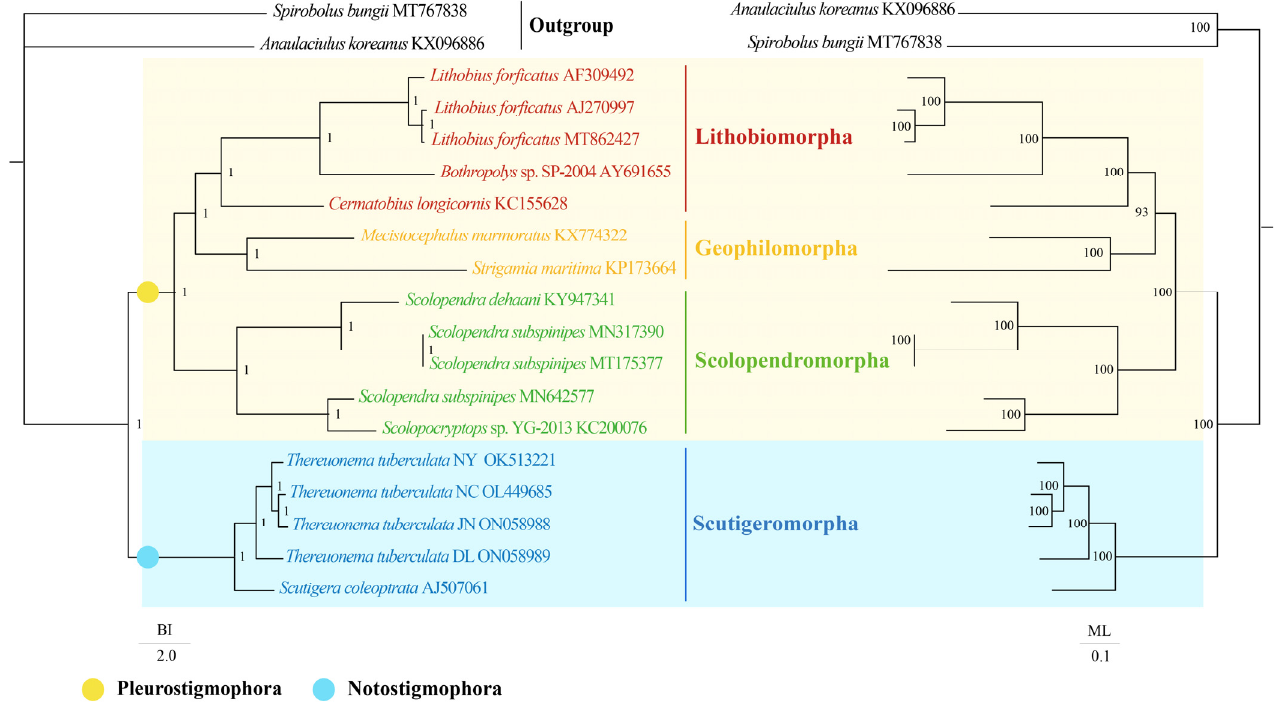
Figure 4. Phylogenetic relationships of Scutigeromorpha inferred from BI analysis ( left ) and ML analysis ( right ) based on 13 mitochondrial protein-coding genes including 17 Chilopoda species. Two species of Diplopoda ( A. koreanus and S. bungii ) were chosen as outgroups. The GenBank accession numbers of all species are shown in the figure. The numbers above the branches specify posterior probabilities as determined from BI ( left ) and bootstrap percentages from ML ( right ).